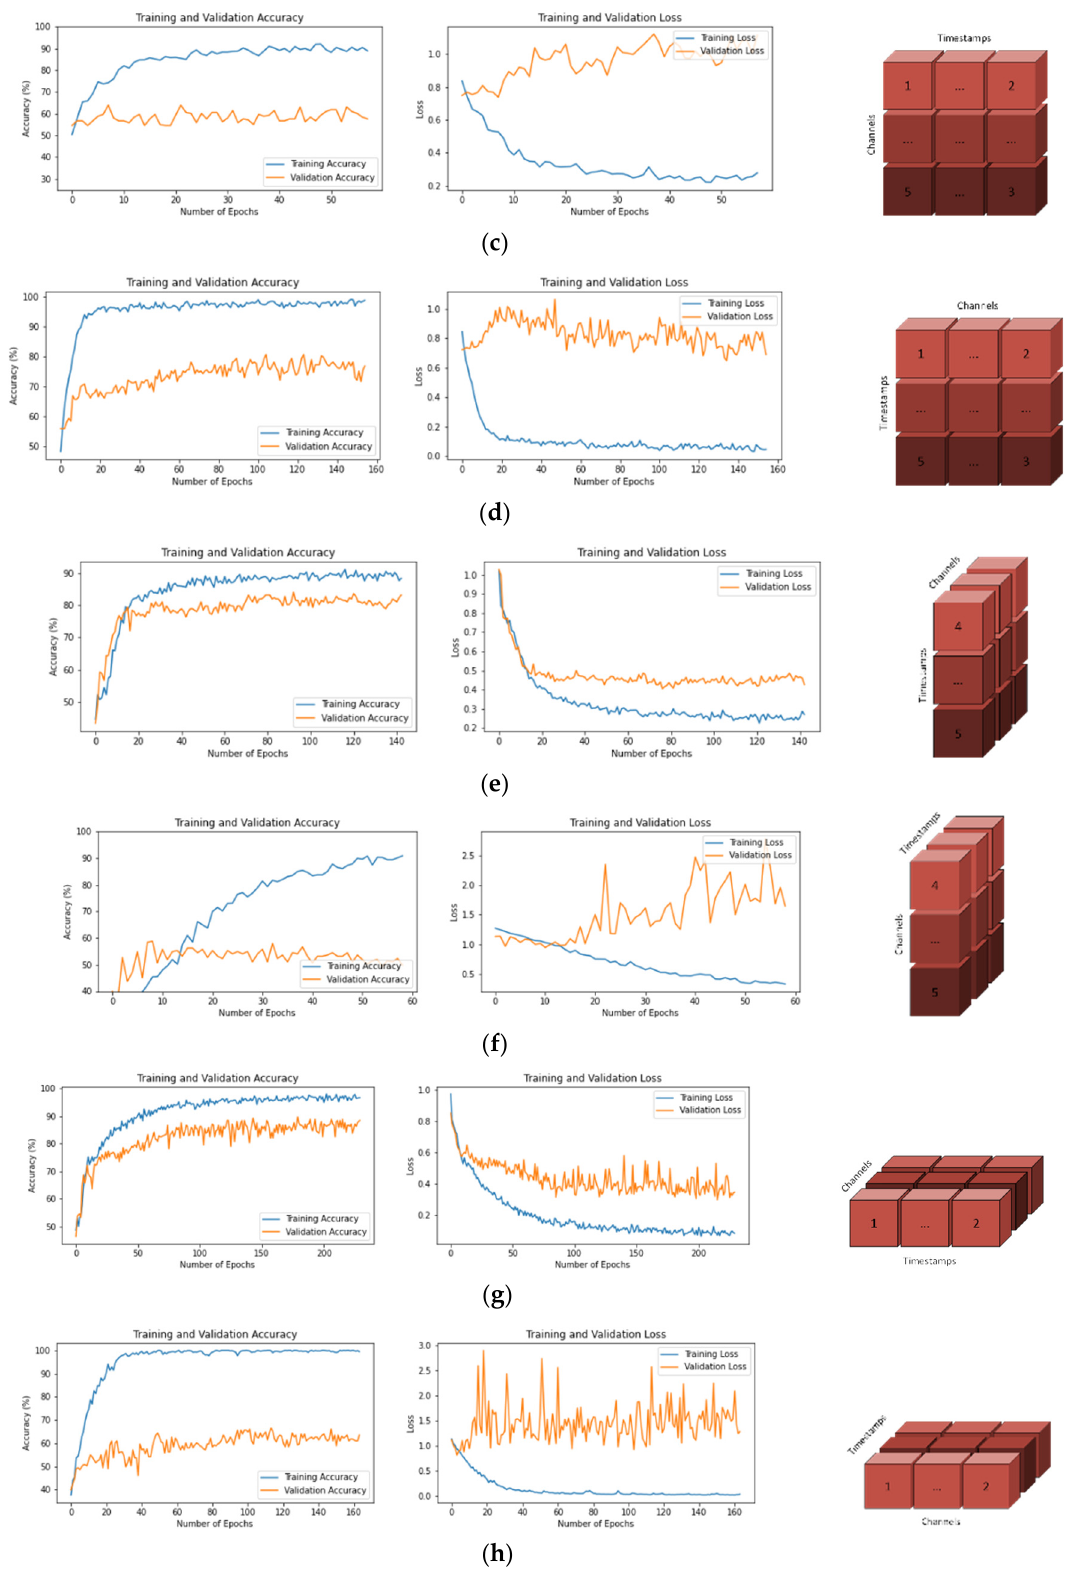
Figure 4. Training—Validation Accuracies and Losses for BCI-IV-2A Dataset and Input Shapes. ( a )